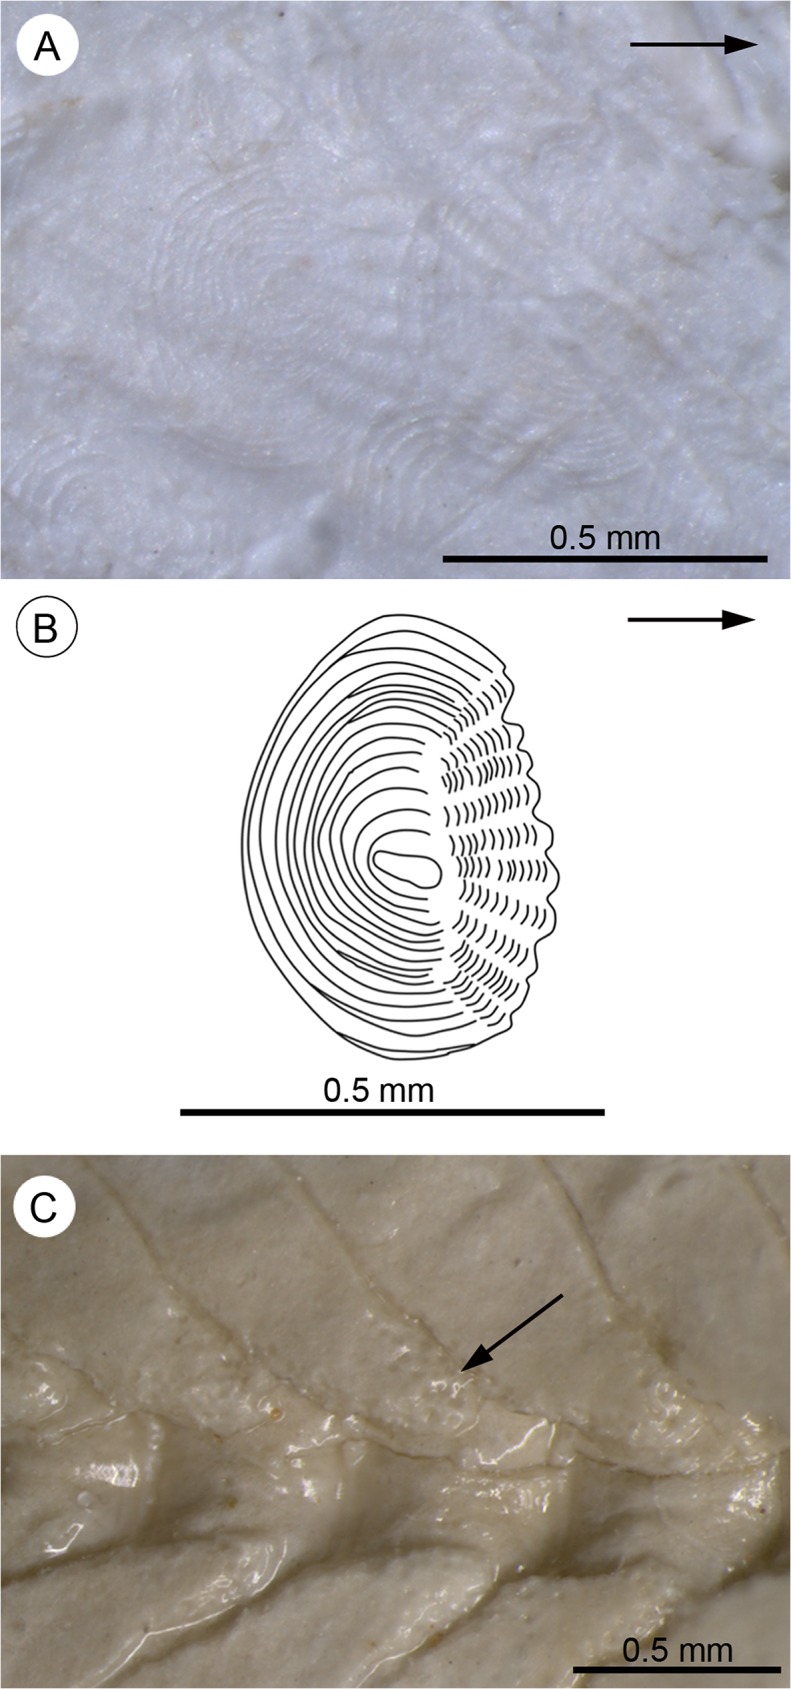
Details of squamation and granulation structures seen in †Kenyaichthys nov. gen.
A Cycloid scales on the pectoral girdle of †Kenyaichthys cf. kipkechi (1223R´04), right lateral view (arrow points anteriorly); B Reconstruction of a cycloid scale on the operculum (based on paratype of †K. kipkechi sp. nov., specimen 1237R(1)´04), mirrored for better comparison (arrow points anteriorly). C Granulation (arrow) on neural spine of caudal vertebra no. 10 (based on †K. kipkechi sp. nov., paratype 1147´04), right lateral view.